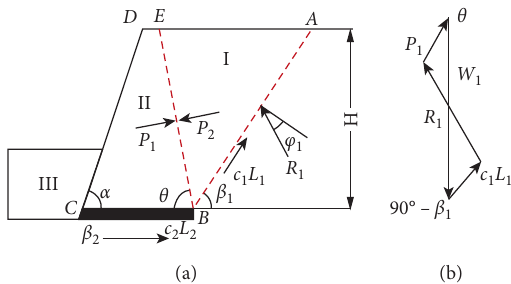
Figure 8: The schematic diagram of structural stability analysis of “slope